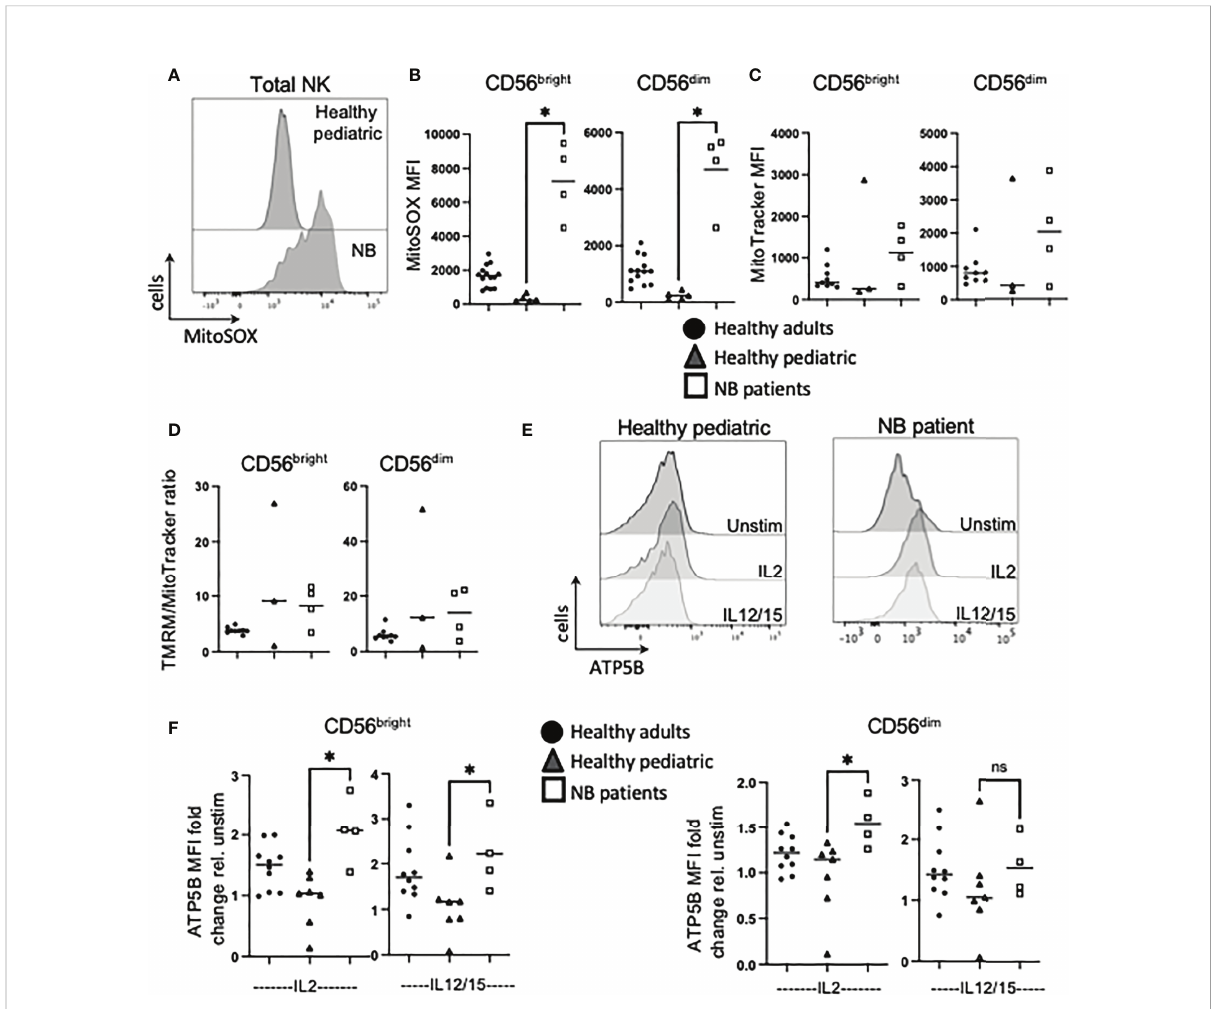
FIGURE 4 NK cells from NB patients display early signs of mitochondrial dysfunction. PBMC were isolated from fresh blood of healthy adult donors, healthy pediatric donors and NB patients. Cells were stimulated with IL2 (500 IU/mL) or IL12 (30 ng/mL) and IL15 (100 ng/mL) at 37°C for 18 hours, where indicated. (A, B) Ex vivo PBMC were stained with MitoSOX (1.5 µM) and analyzed by fl ow cytometry. (C) Ex vivo PBMC were stained with MitoTracker Green (100nM) and analyzed by fl ow cytometry. (D) Ex vivo PBMC were stained with TMRM (100nM) and MitoTracker Green (100uM), and analyzed by fl ow cytometry. (E, F) Cells were stained for ATP5B and analyzed by fl ow cytometry. Samples were compared using the Two-way ANOVA test. ns, not signi fi cant; *